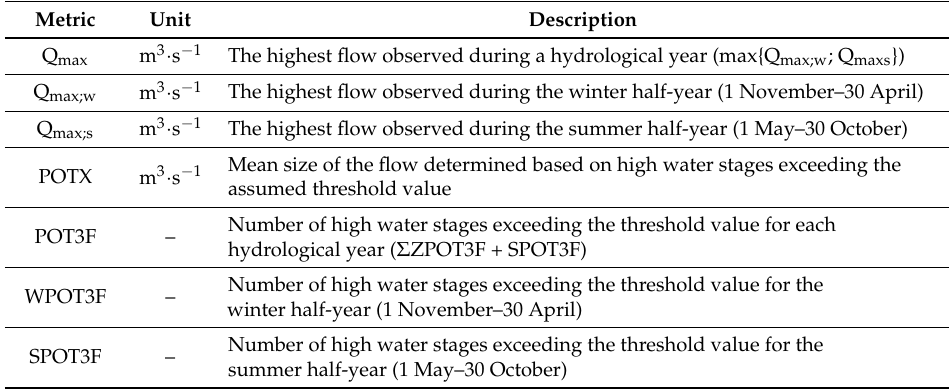
Table 1. Analyzed metrics of high water stages (source: authors’ own